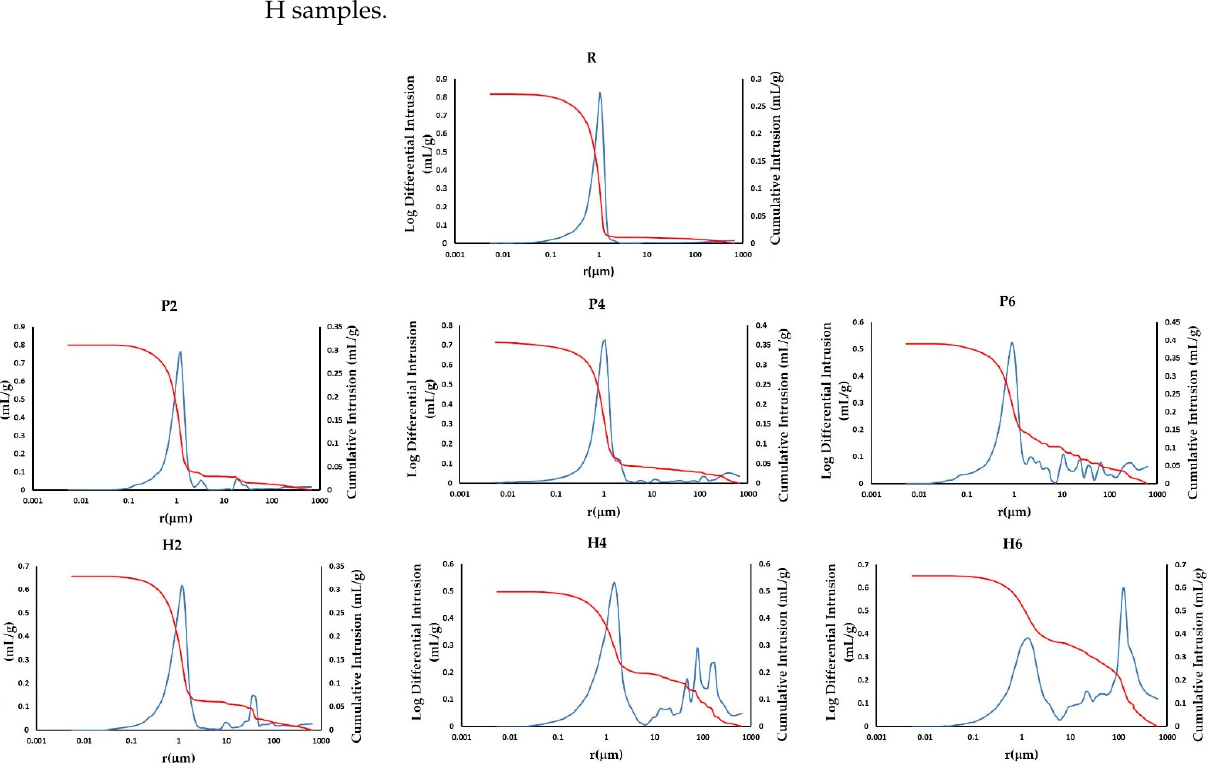
Figure 7. Cumulative mercury intrusion (red) and pore size distribution (blue) curves for the samples without additives (R) and for those with added EPS (P) and olive stones